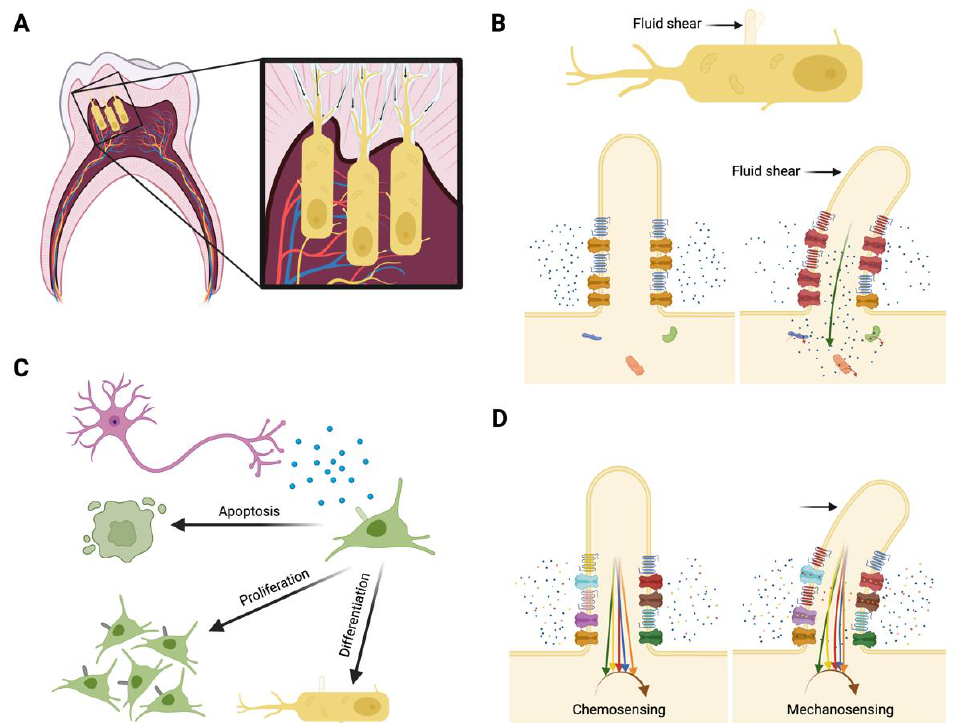
Figure 4. Summary of proposed future directions for dental primary cilia research. ( A ) Primary cilia may be important for odontoblasts (yellow) to sense physical stimuli from compression of the tooth and/or fluid shear (black arrows) through the dentinal tubules. ( B ) Fluid shear through the dentinal tubules may elicit an intracellular calcium response (green arrow) in odontoblasts that is mediated by the primary cilium. The axoneme bends in the direction of the fluid, causing calcium ion channels (yellow) to open (red) so that calcium (blue spheres) enters the ciliary complex and binds to proteins, triggering intracellular signaling cascades (red arrows). ( C ) During inflammation and injury, sensory nerves (purple) secrete factors that regulate dental stem cell (green) apoptosis, proliferation, and odontogenic differentiation in mechanisms that are potentially mediated by dental stem cell primary cilia. ( D ) Components associated with several signaling pathways (represented by different colors) are regulated simultaneously by the primary cilium in both chemo- and mechanotransduction. The individual contribution of each pathway is synchronized by the primary cilium to produce a coordinated intracellular response (brown arrow). This figure was created with BioRender.com